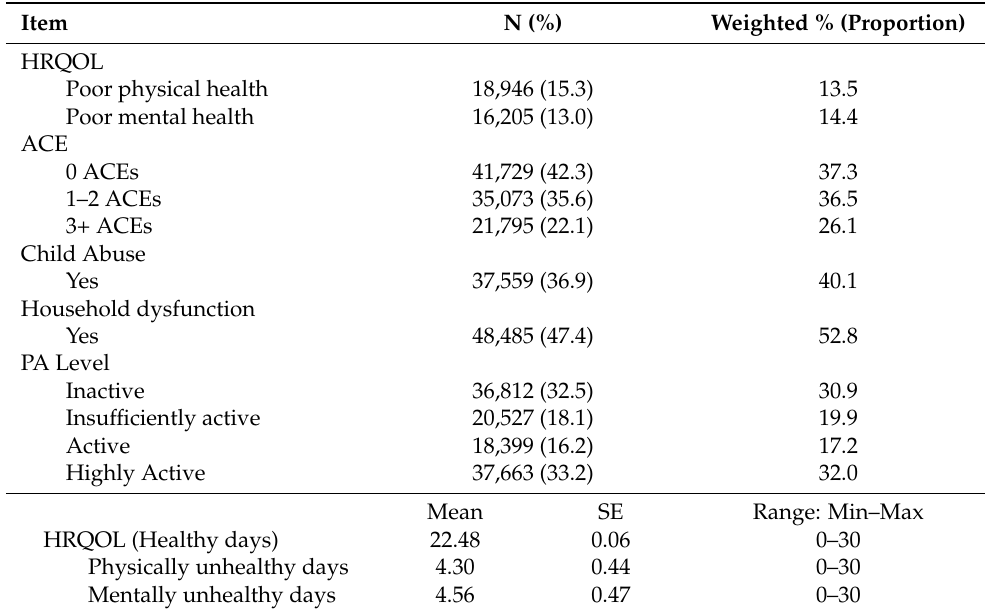
Table 2. Univariate analysis of key variables ( n =